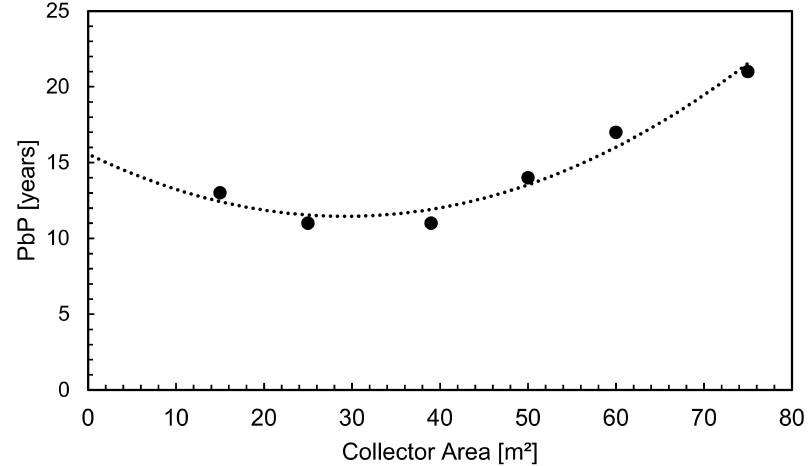
Figure 10. Payback period analysis for the solar-adsorption cooling system under di ff erent solar collector